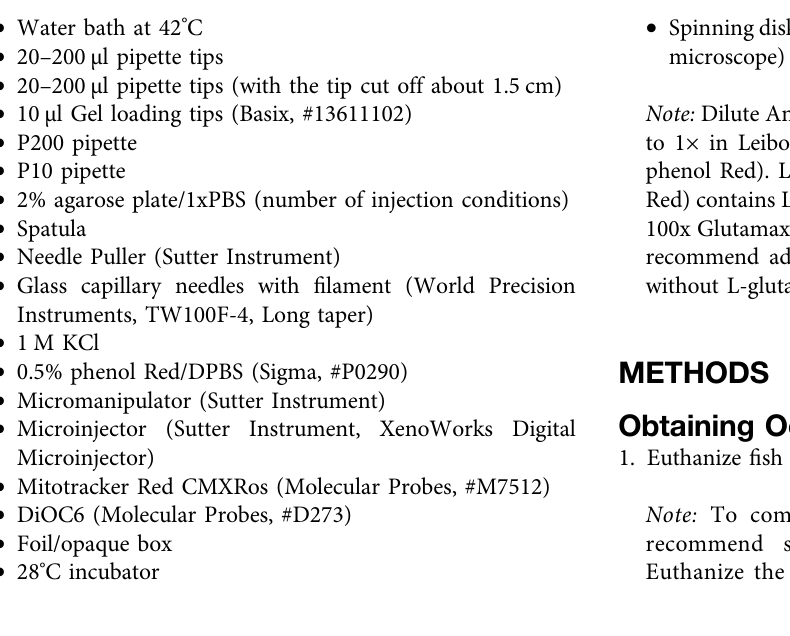
Frontiers in Cell and Developmental Biology |